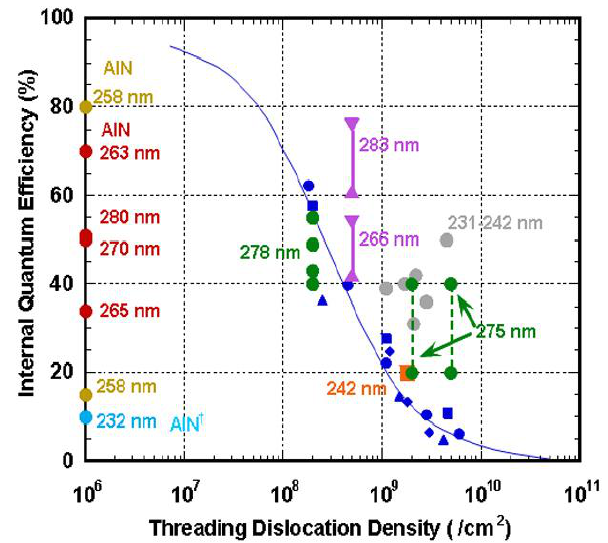
Figure 18. The reported IQEs as a function of TDD are mapped. The data for the flat AlGaN MQWs determined under nonsaturated conditions are plotted with ● [61], ● [137], ●■ [24,25], ■ [90] and ● [136] solid symbols. The solid blue plots are the measured IQEs considering excitation conditions for the flat MQWs with wavelengths 230 nm ( ● ), 250 nm ( ■ ), 300 nm ( ◆ ), and 350 nm ( ▲ ), and the blue curve show the relationship between TDD and IQE [77]. AlN indicates the use of the bulk AlN substrate, which is gathered at TDD of 10 6 /cm 2 . The violet symbols denote the uneven MQWs on macrosteps for our samples from Table 2. The gray circles (●) indicate the IQE boosted by Si-doped MQW [90] and the rest is considered to be data for undoped MQWs (colored symbols). AlN † indicates the uneven QWs.